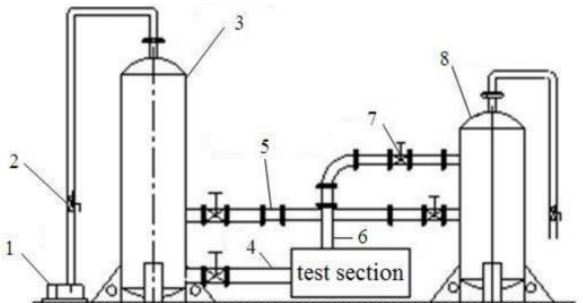
Figure 15. Schematic diagram of the transient characteristic experimental set-up [78]. 1. Vacuum pump; 2. Ball valve; 3. Cavitation-tank; 4. Water inlet; 5. Turbine flowmeter; 6. Water outlet; 7. Butterfly bumper; 8. Buffer tank.